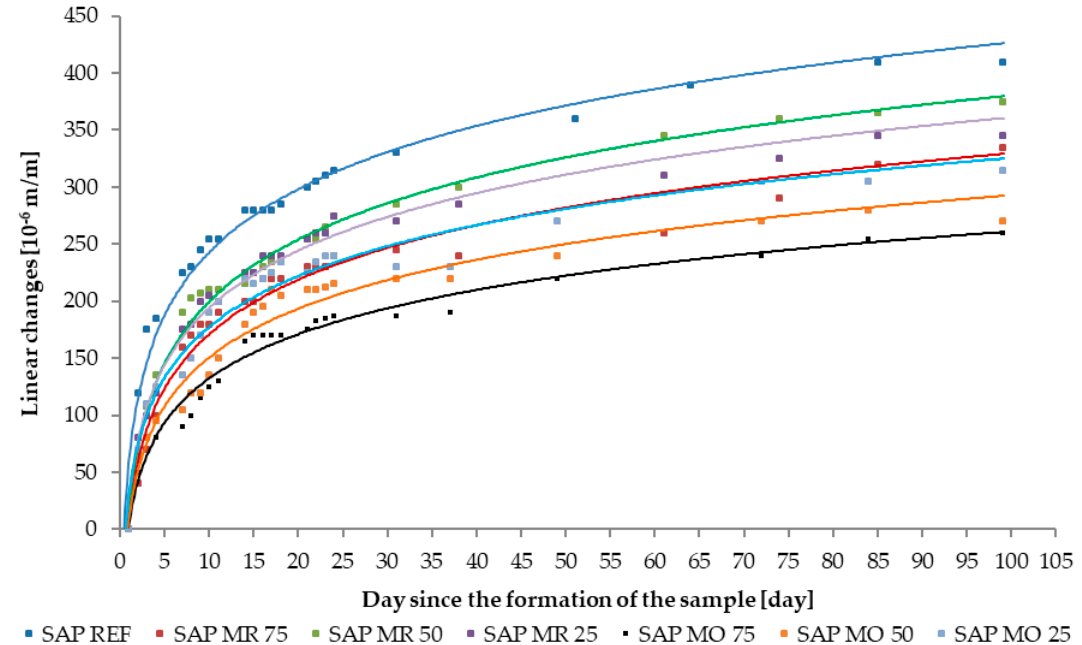
Figure 8. The effect of dosing method on the autogenous shrinkage of series modified with fine grade superabsorbent polymers (SAP), (SAP M). The linear changes axis presents shrinkage, not expansion.